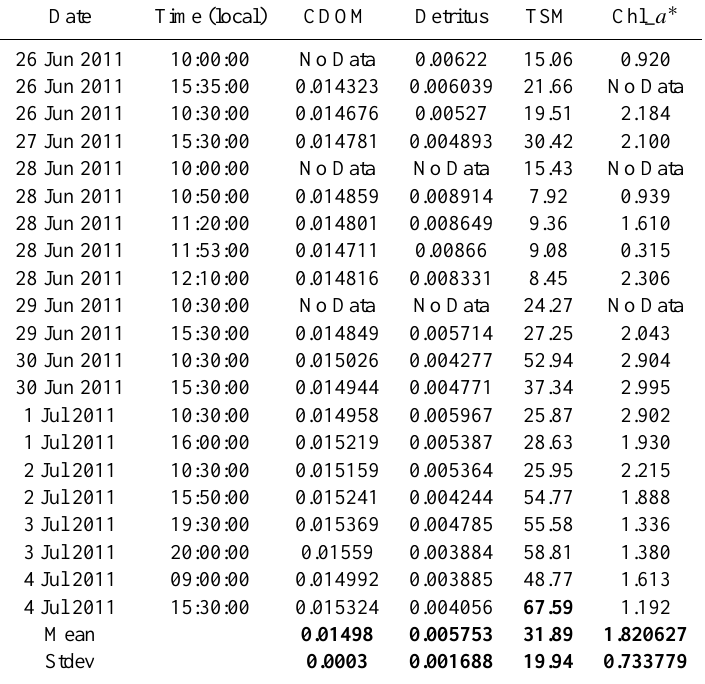
Table 3. Slopes of CDOM and detritus absorption and concentrations of total suspended matter mgL − 1 , and chlorophyll a µgL − 1 (including all degradation products). Given below are the overall means and standard deviations.